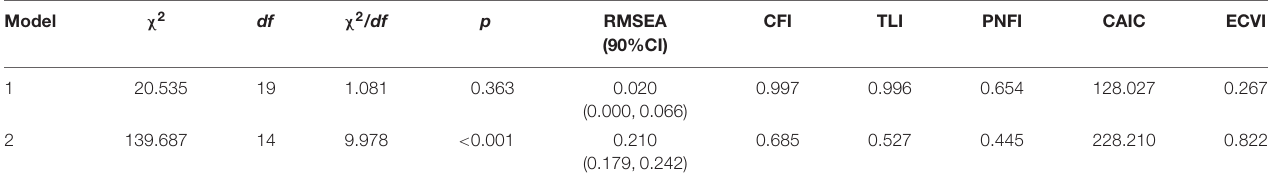
TABLE 3 | The fit indices for competing confirmatory factor analytic models of the COIQ (Study 1, n Study 1 − CFA = 205). Model χ 2